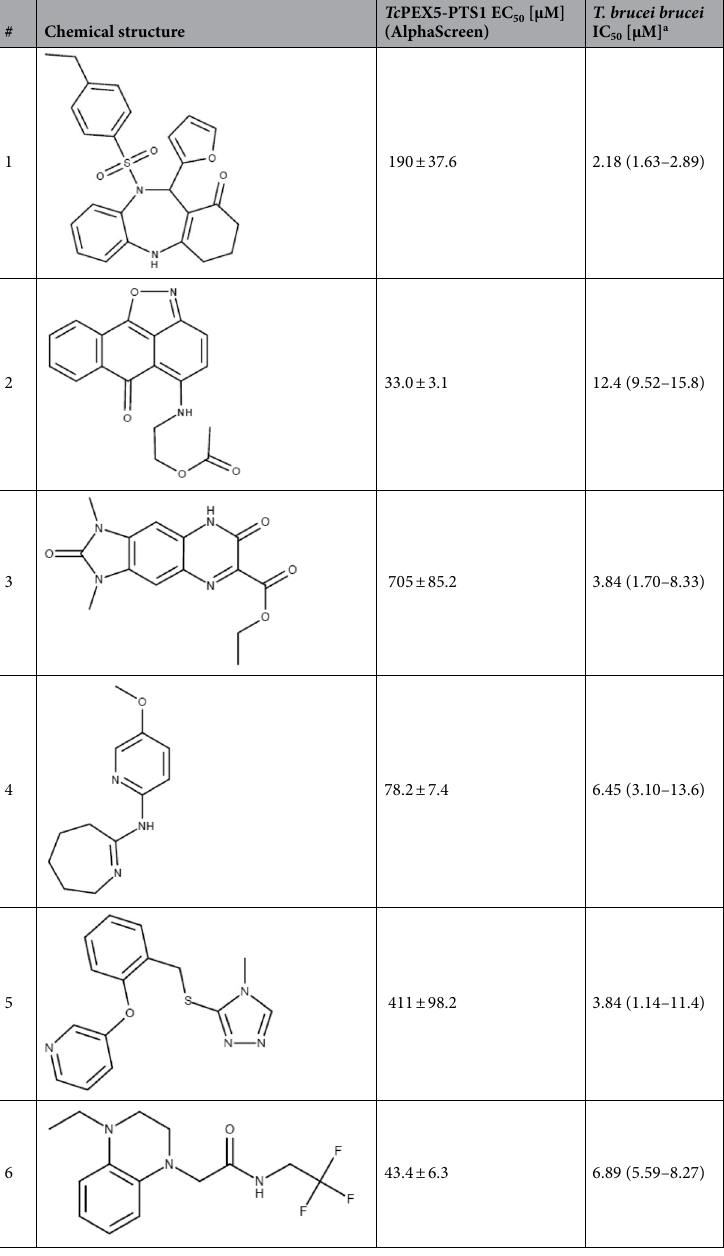
Table 1. Chemical structures, EC 50 values (AlphaScreen) and trypanocidal activity of hit compounds identified in this study. a EC 50 values are shown as mean (n = 4). Values in parentheses are 95% confidence